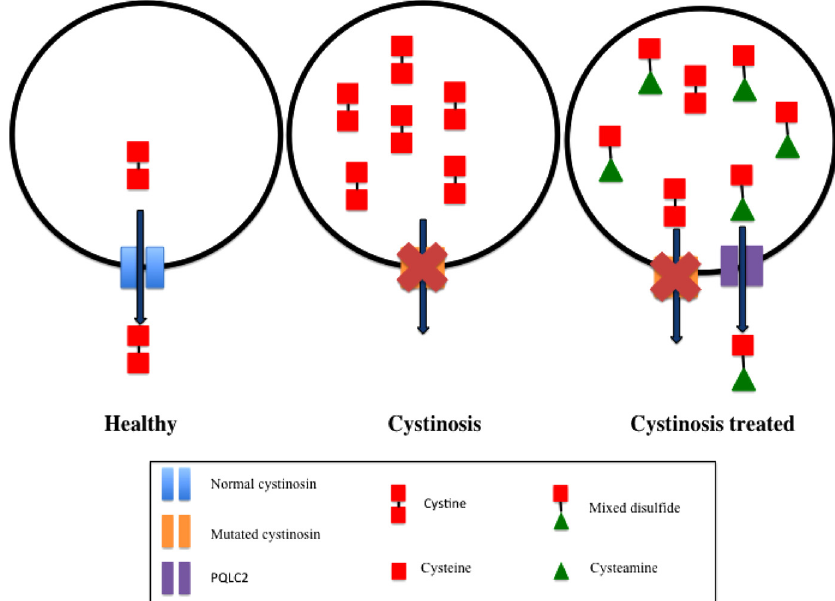
Fig. 1. Cysteamine prevents cystine accumulation in lysosomes (C. Brétaudeau). In healthy patients, cystine is exported from lysosomes by a speci fi c protein, cystinosin. In cystinotic cells, cystinosin is inef fi cient and cystine accumulates into cells. The speci fi c treatment, cysteamine replaces one cysteine creating a mixed disul fi de molecule, and allowing it to exit the lysosome by an other transmembrane protein, PQLC2.